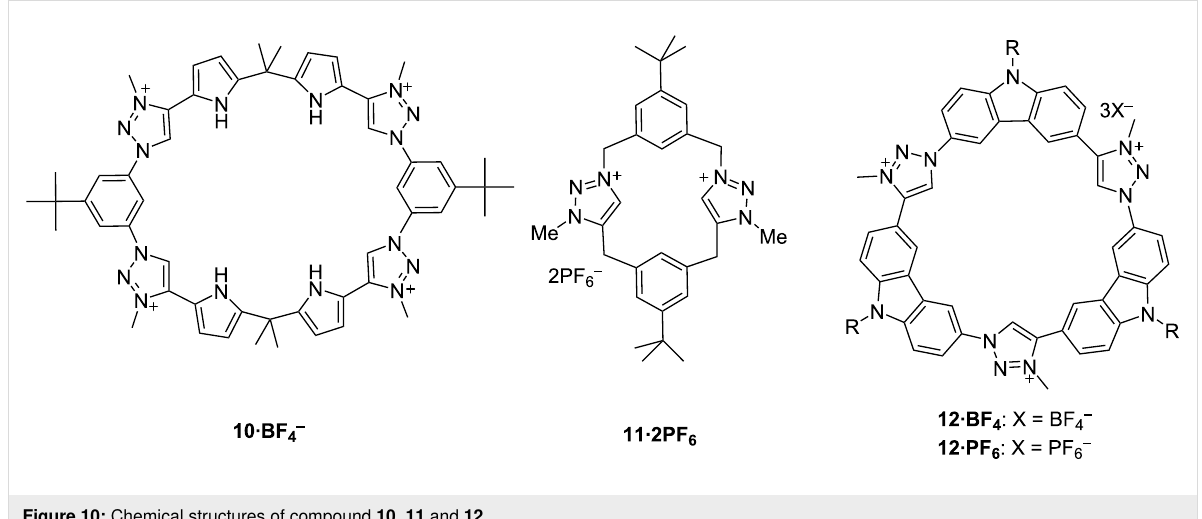
Figure 10: Chemical structures of compound 10 , 11 and 12 .